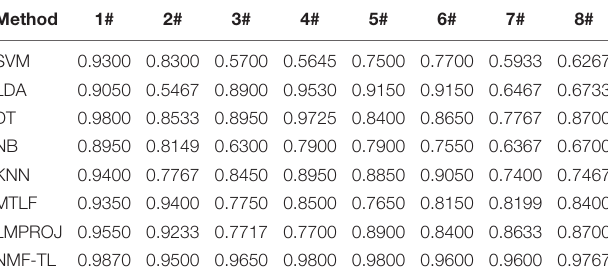
TABLE 5 | Classification accuracy comparison of 8 classifiers on datasets based on KPCA feature